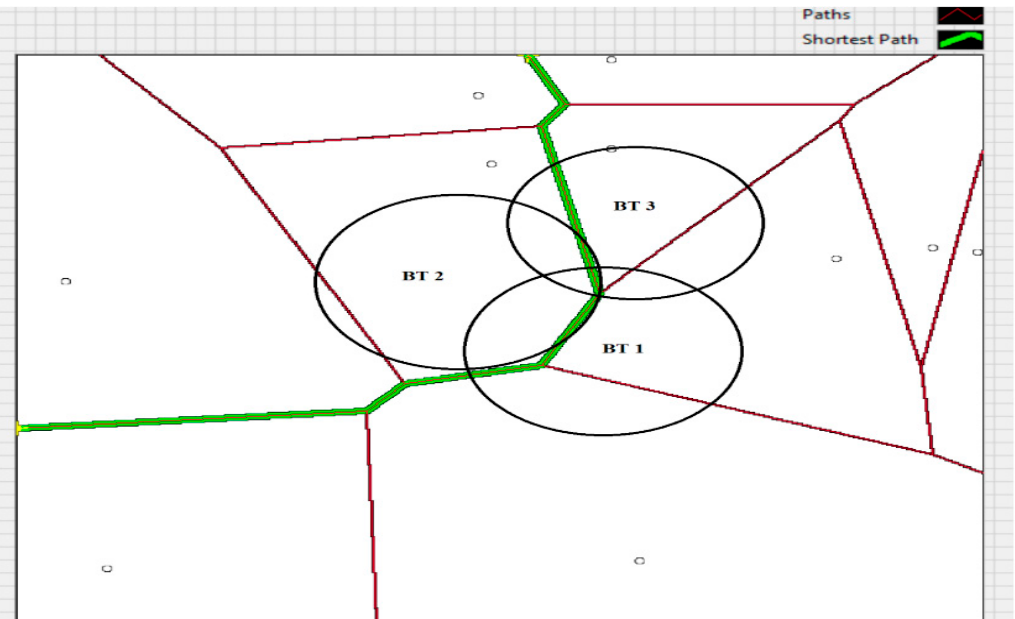
Figure 24. Tracking trajectory for subject 5, using the proposed system.